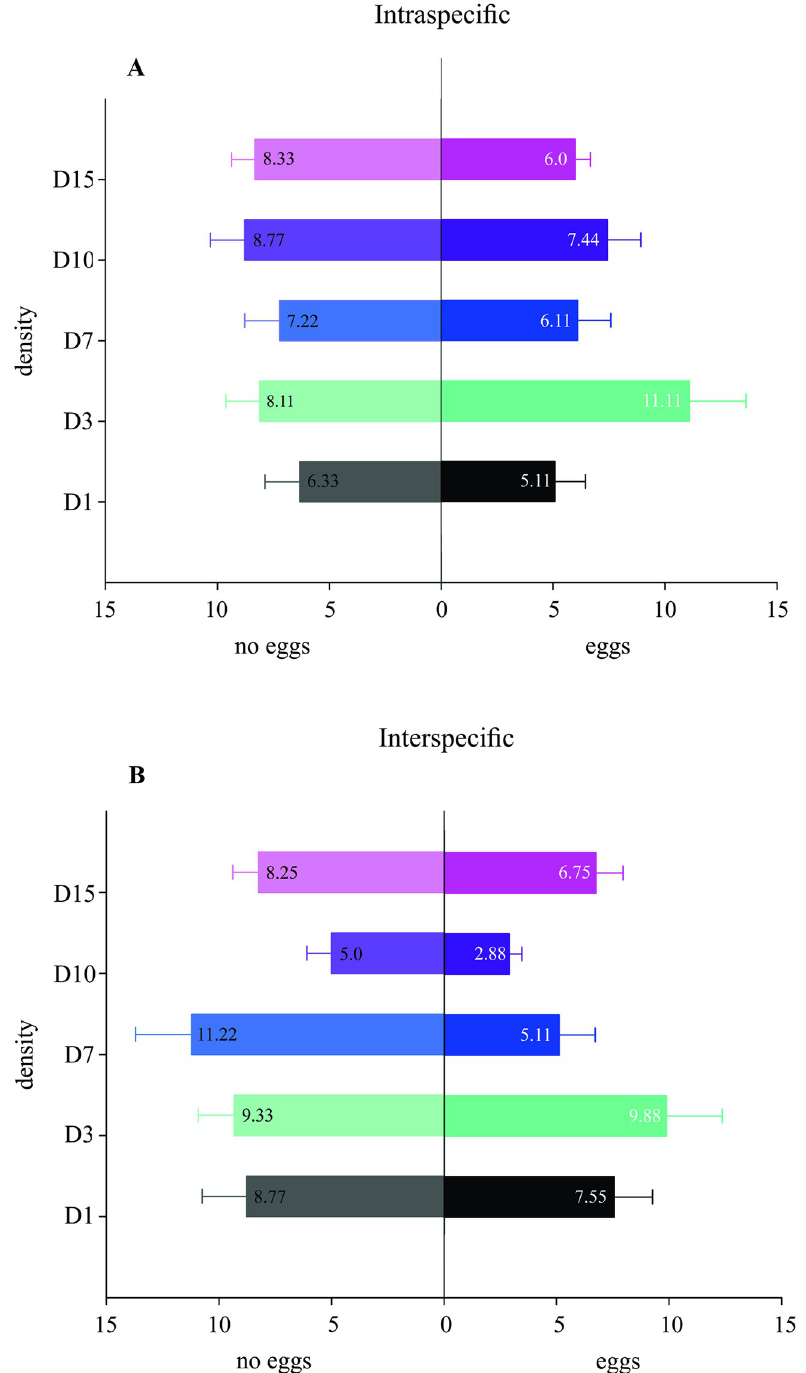
Fig 6. Choice behavior of Drosophila suzukii with eggs of Zaprionus indianus or with eggs of D . suzukii . Experiments indicating the total eggs laid by D . suzukii on a diet previously infested with different egg densities (1, 3, 7, 10, or 15 eggs) versus a blank diet. (A) Intraspecific: oviposition behavior of D . suzukii in one diet with eggs of D . suzukii versus a blank diet (no eggs). (B) Interspecific: oviposition behavior of D . suzukii in one diet with eggs of Zaprionus indianus versus a blank diet (no